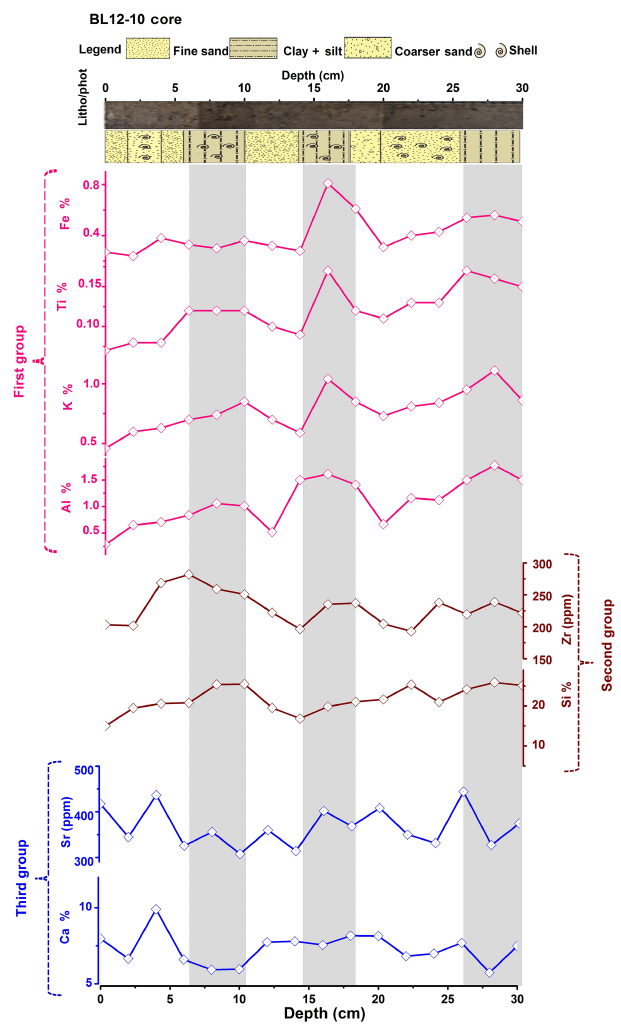
Figure 11. Records of eight geochemical elements (expressed in percentage or ppm) versus depth in core